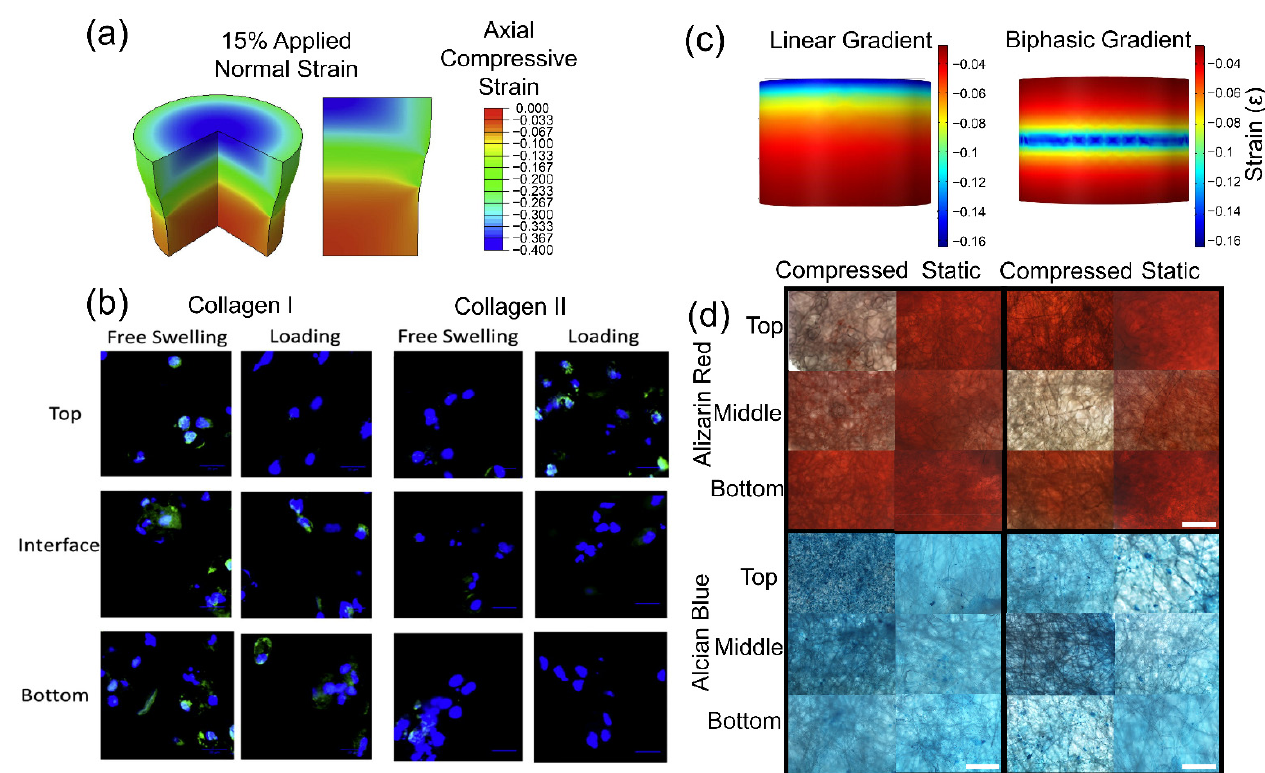
Figure 3. Effect of compressive strain gradient on osteogenic and chondrogenic differentiation. ( a ) A computational model describing a compressive strain gradient through the thickness of multi-layer hydrogel. ( b ) Collagen I and Collagen II expression of cells cultured in the hydrogel with or without applying compressive loading showing differential osteogenic and chondrogenic differentiation levels depending on the magnitude of local compressive strain [106]. ( c ) Computational modeling to design linear or biphasic strain gradient within a monolithic 3D electrospun core–shell nanofibrous scaffold via variable core–shell ratio. ( d ) Histology images of cell/scaffold constructs showing compressive strain gradient-dependent osteogenic (Alizarin red staining) and chondrogenic (Alcian blue staining) differentiation within the individual scaffolds [96].